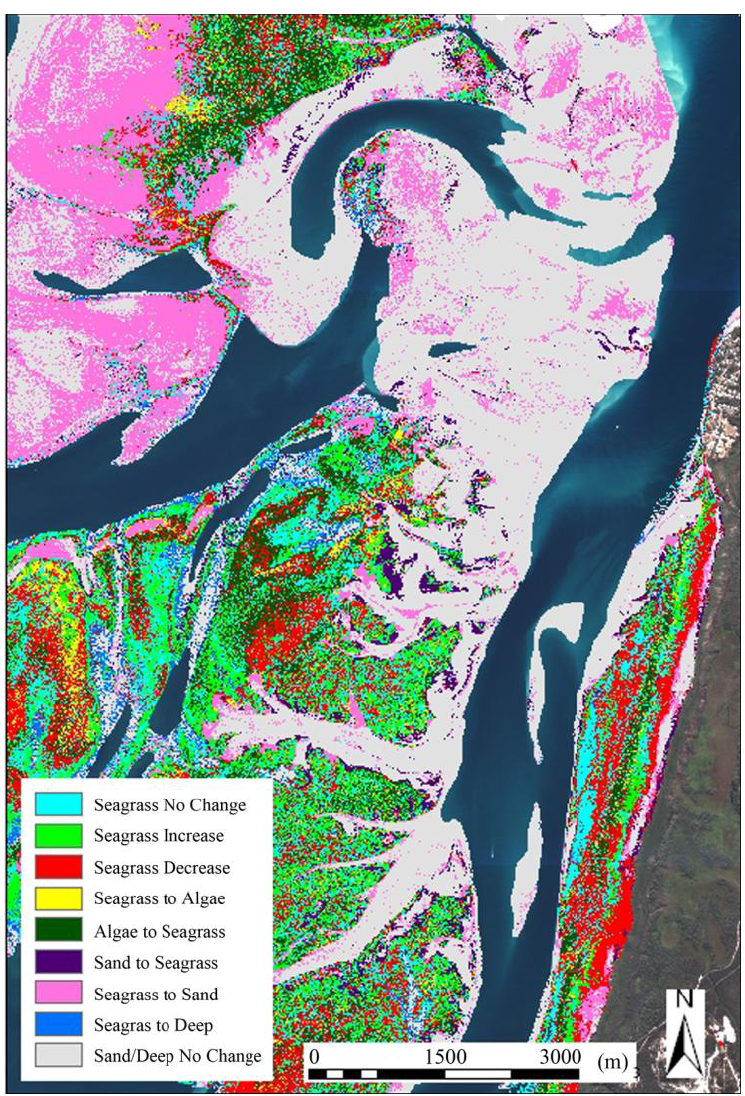
Figure 9 . Post classification change image, showing changes in seagrass cover level or substrate type from 2004 to